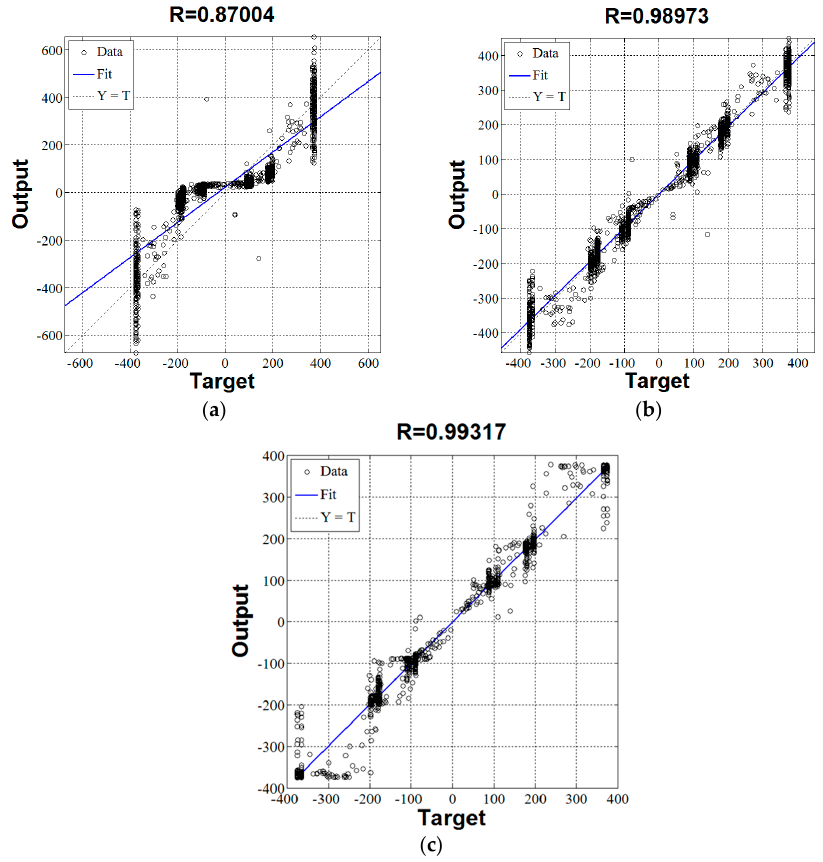
Figure 10. Performance plots of SVR for three types of kernel functions. ( a ) Plot of polynomial kernel function; ( b ) Plot of sigmoid kernel function ( c ) Plot of Gaussian kernel function. function; ( b ) Plot of sigmoid kernel function ( c ) Plot of Gaussian kernel